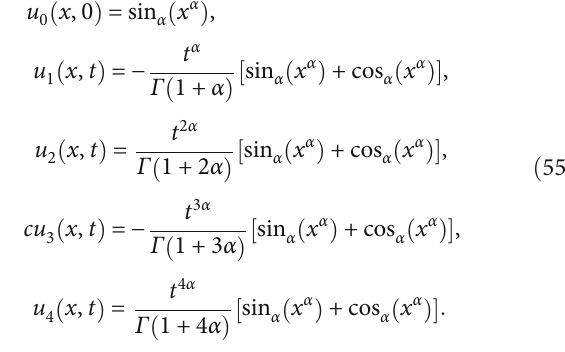
Figure 3: Variation of u ð x , t Þ versus x , with α = ln 2/ln 3 , t = 0 : 2, 0 : 5, 0 : 8 sec .